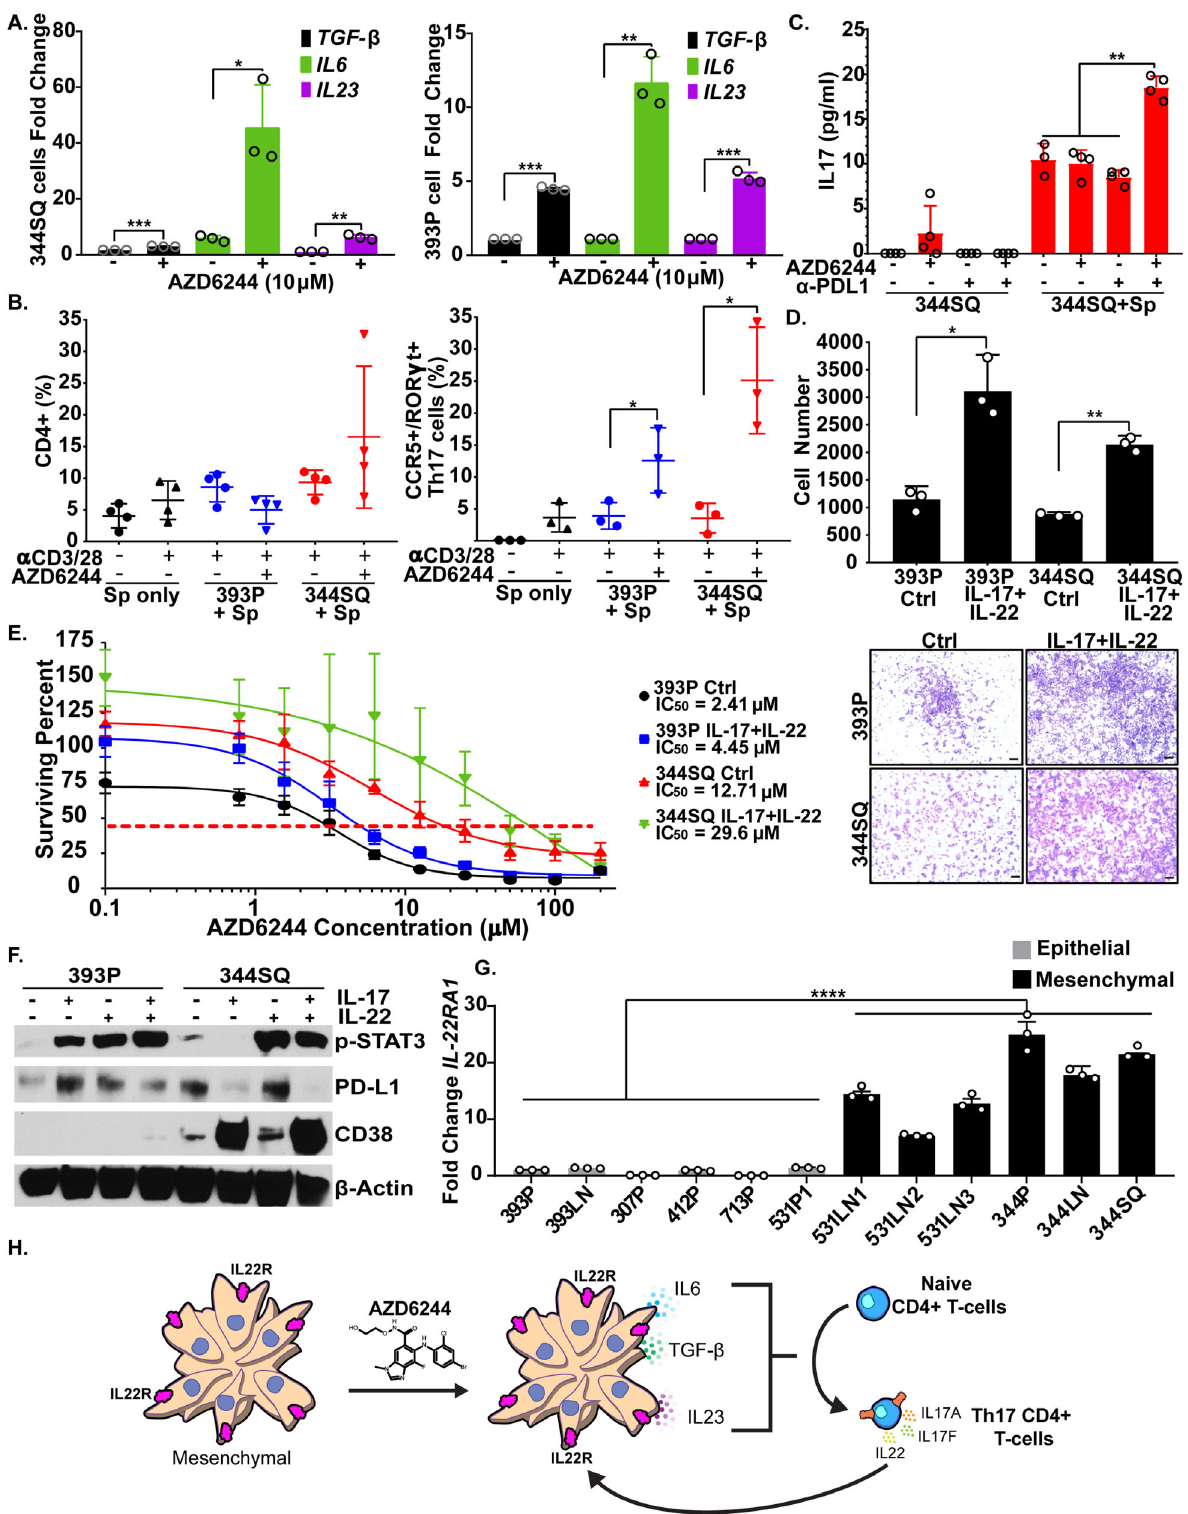
effects of the increased IL-17 production, therapeutic antibody neutralization of IL-17 was combined with MEK inhibition, PD- L1 checkpoint blockade, or MEK inhibitor plus anti-PD-L1 combination in 344SQ tumors starting 3 weeks post implantation in mice. Initial treatment of 344SQ tumors demonstrated that the triple therapy most signi fi cantly reduced primary tumor